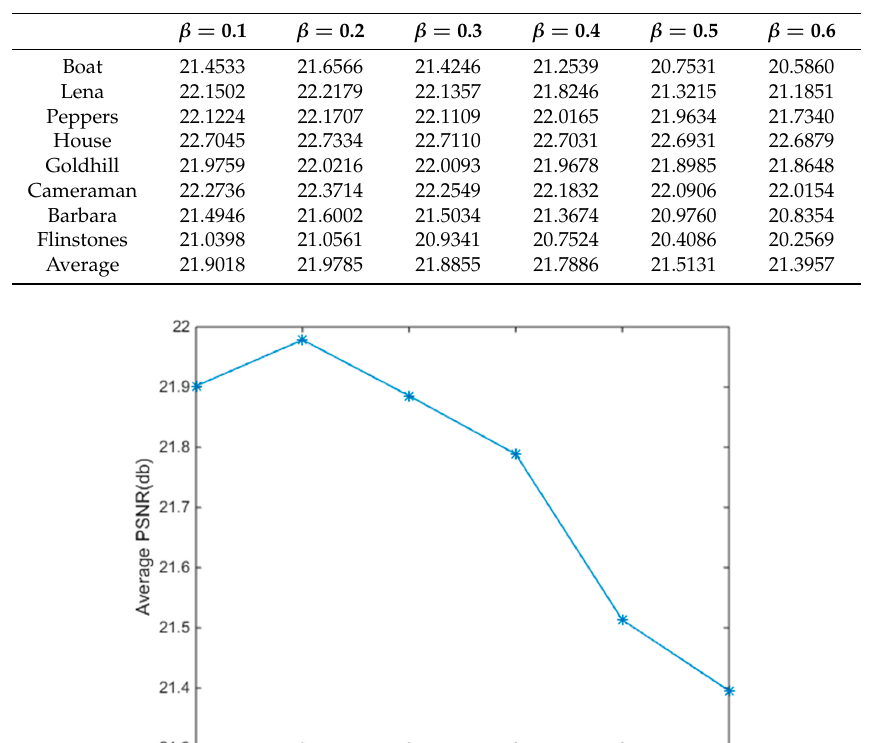
Table 3. Objective result (in PSNR, dB) of each image under a different β .